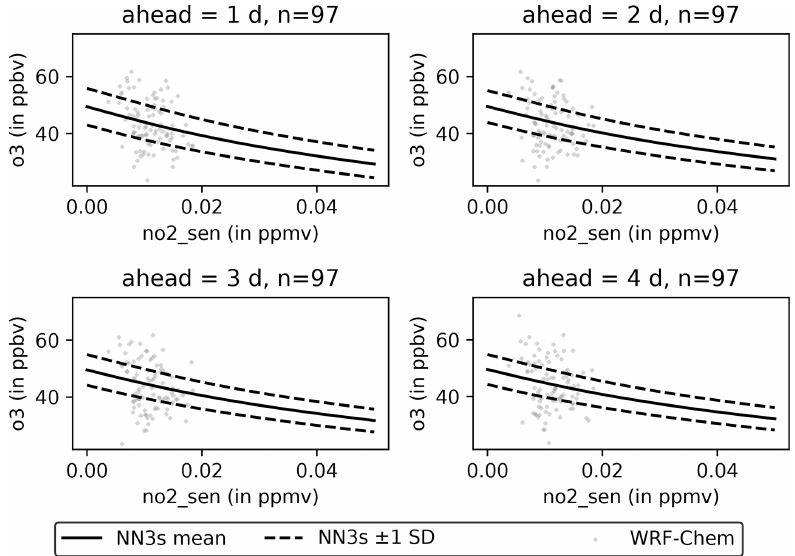
Figure 14. Same as Fig. 11 but for NO 2 instead of ozone